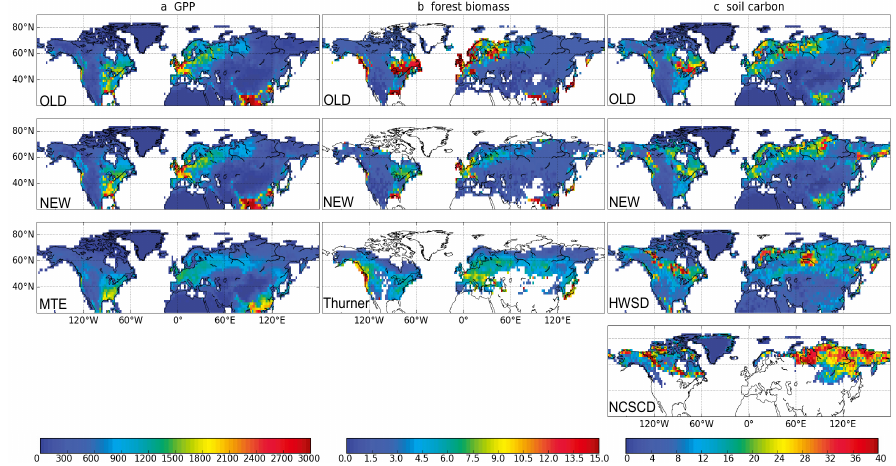
Figure 11. Spatial pattern of (a) mean annual GPP (gCm − 2 yr − 1 ) during 1999–2008 from OLD, NEW, and MTE (Jung et al., 2011); (b) forest biomass density (per forest area, kgCm − 2 forest) from OLD, NEW and Thurner et al. (2014); and (c) total soil carbon density (kgCm − 2 ) simulated by OLD and NEW (0–2m depth), and from HWSD (0–1m depth) and NCSCD (0–1m depth).